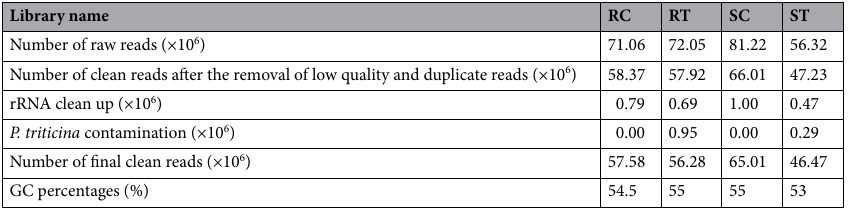
Table 1. Sequencing statistics of the four transcriptome samples in two Ae. tauschii accessions inoculated with P. triticina pathotype CDHLQ at the seedling stage (RT and ST) and mock-inoculated ones (RC and SC). RC resistant control, RT resistant treatment, SC susceptible control, ST susceptible treatment.